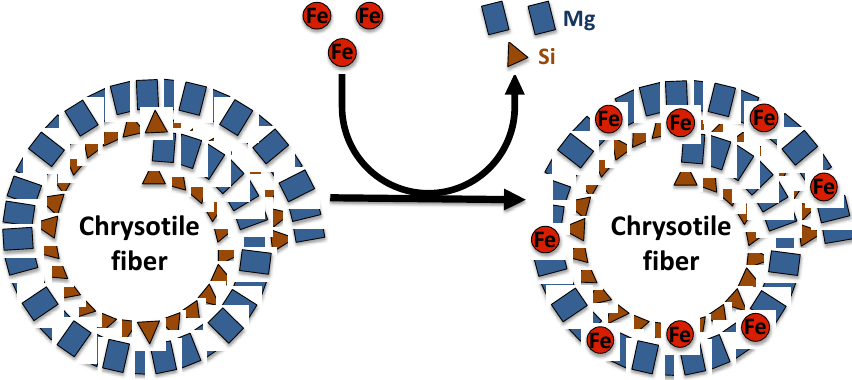
Figure 1. Representation of magnesium and silicon substitution by iron in the chrysotile fiber structure.